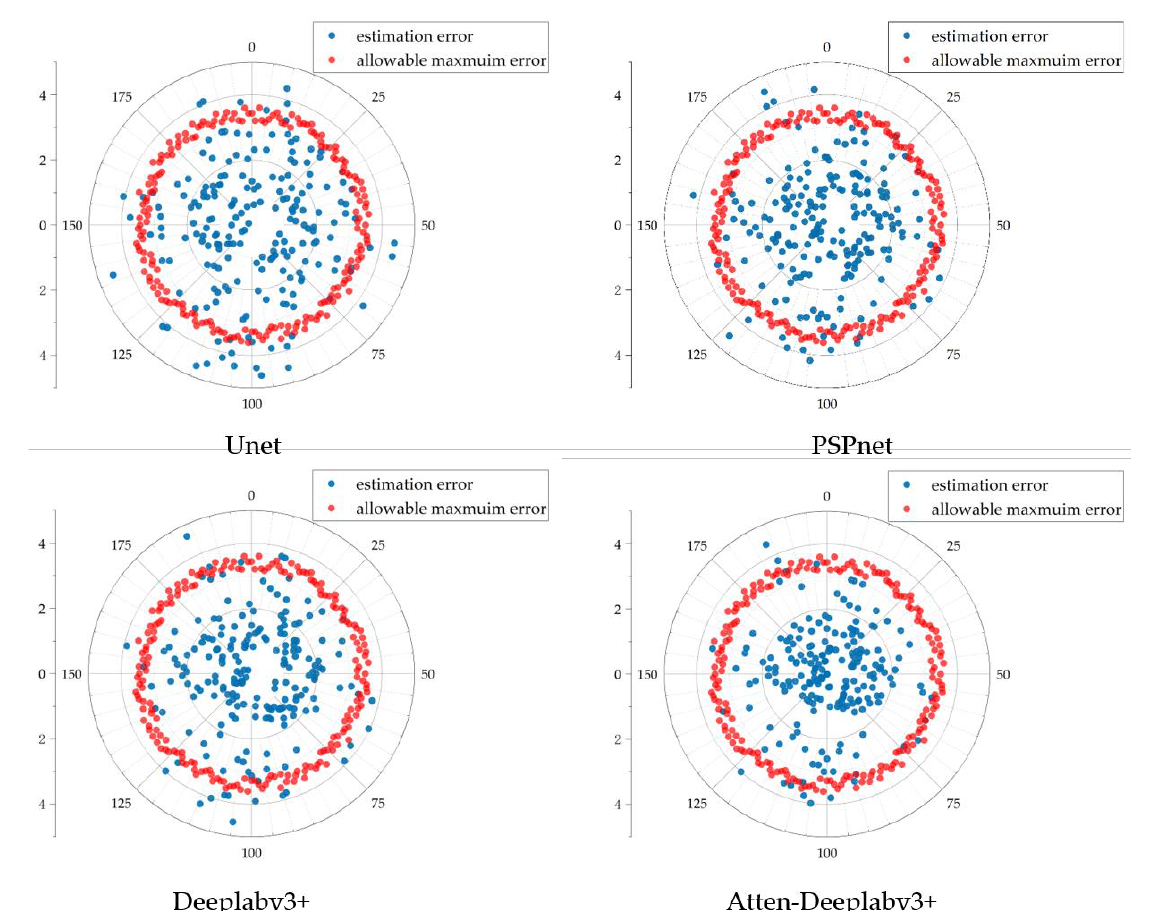
Figure 9. The error of injection position for each